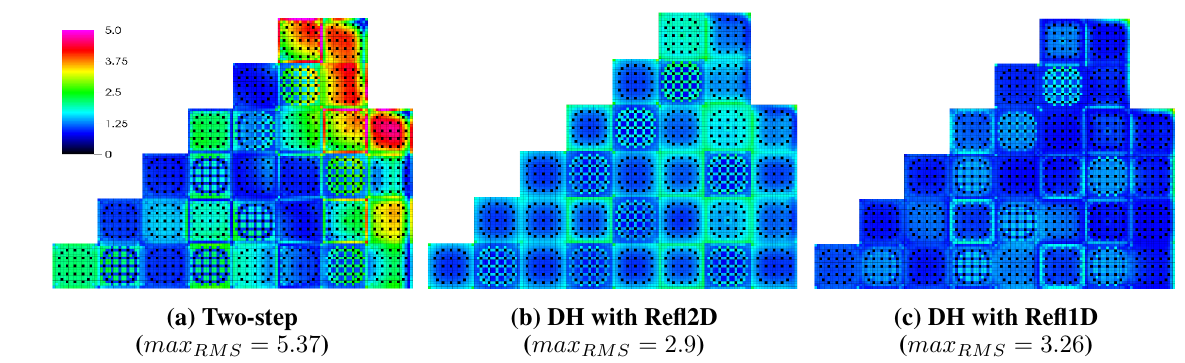
Figure 4: RMS of power axial error per pin.